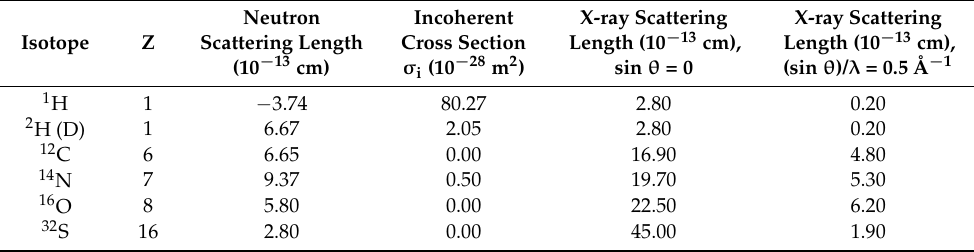
Table 1. Neutron and X-ray scattering lengths for atom types commonly found in proteins §